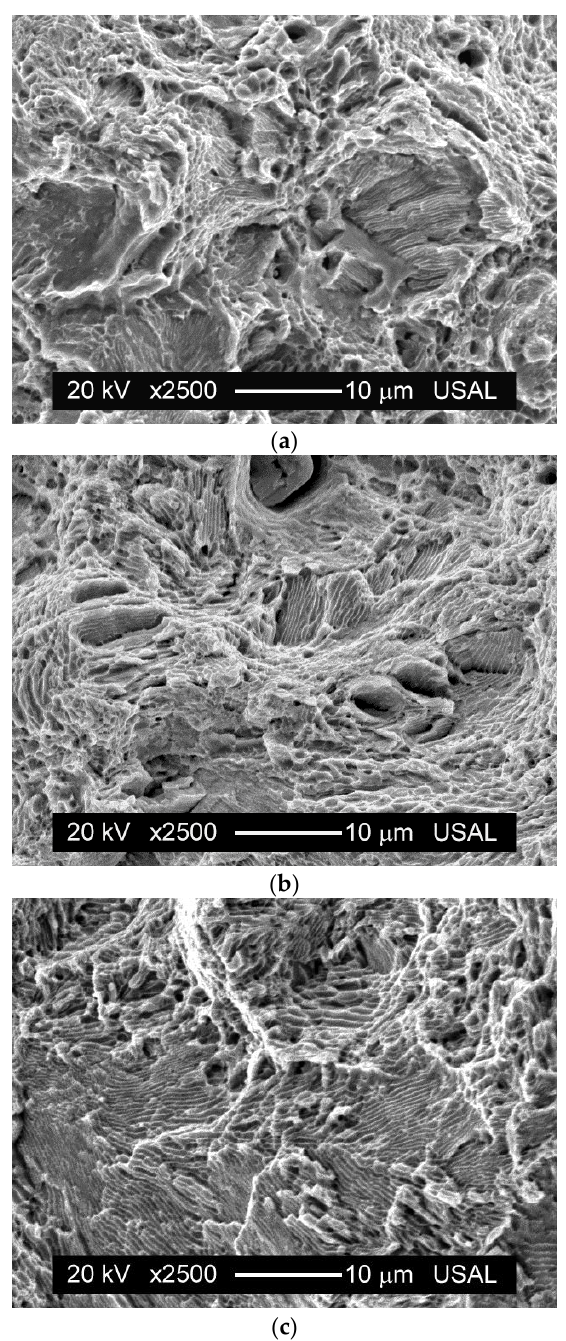
Figure 7. Fracture process zone (FPZ) in the steels cooled using: ( a ) AC; ( b ) POF; ( c ) FCF.